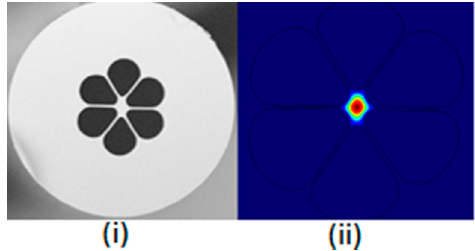
Figure 15. SEM micrograph of the cross-section of solid core polarization-maintaining PCF and its optical mode profile (Reproduced from [32], with the permission of Elsevier publishing).